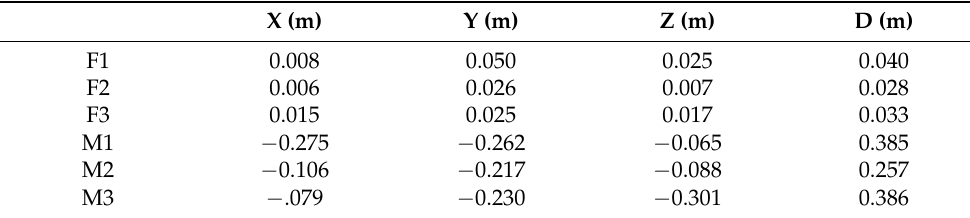
Table 2. Differential of the X, Y and Z coordinates and total displacement of the measured points. Units in